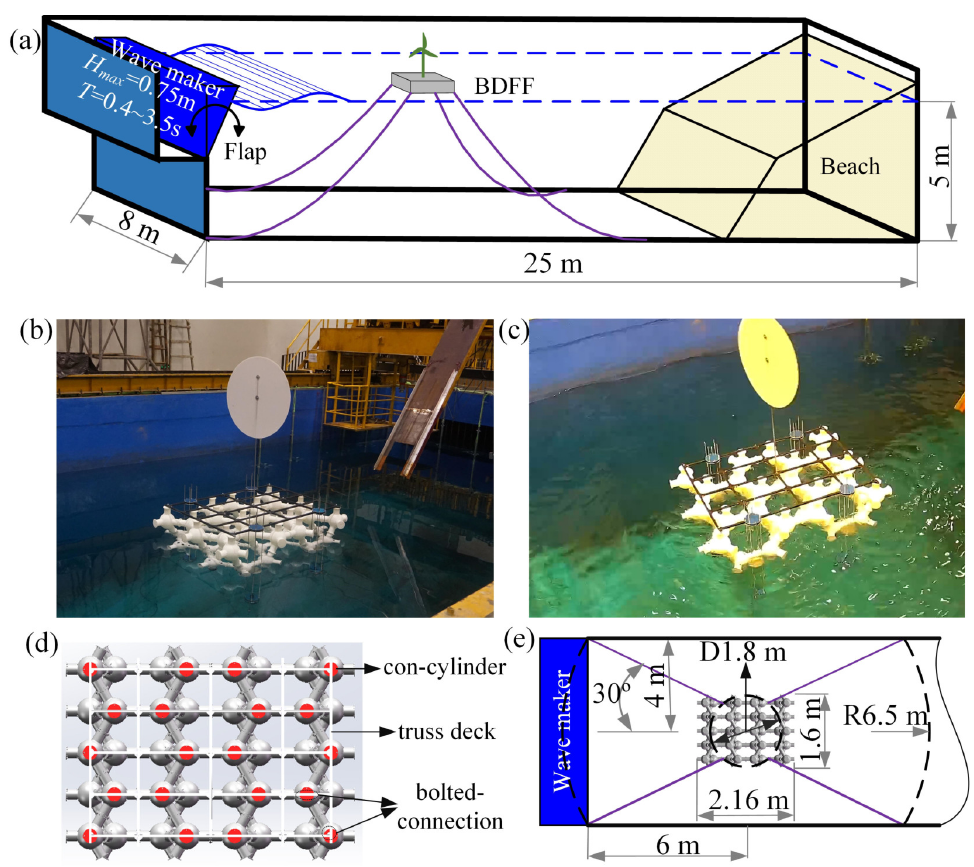
Figure 11. ( a ) Sketch of the wave basin. ( b ) The test model moored in still water. ( c ) The test model moored in waves. ( d ) The connection between the truss deck and the floaters. ( e ) The model dimension and the mooring